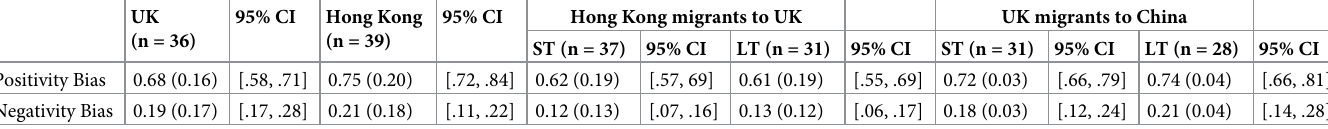
Table 3. Means (standard deviations) on scrambled sentences task (proportion of